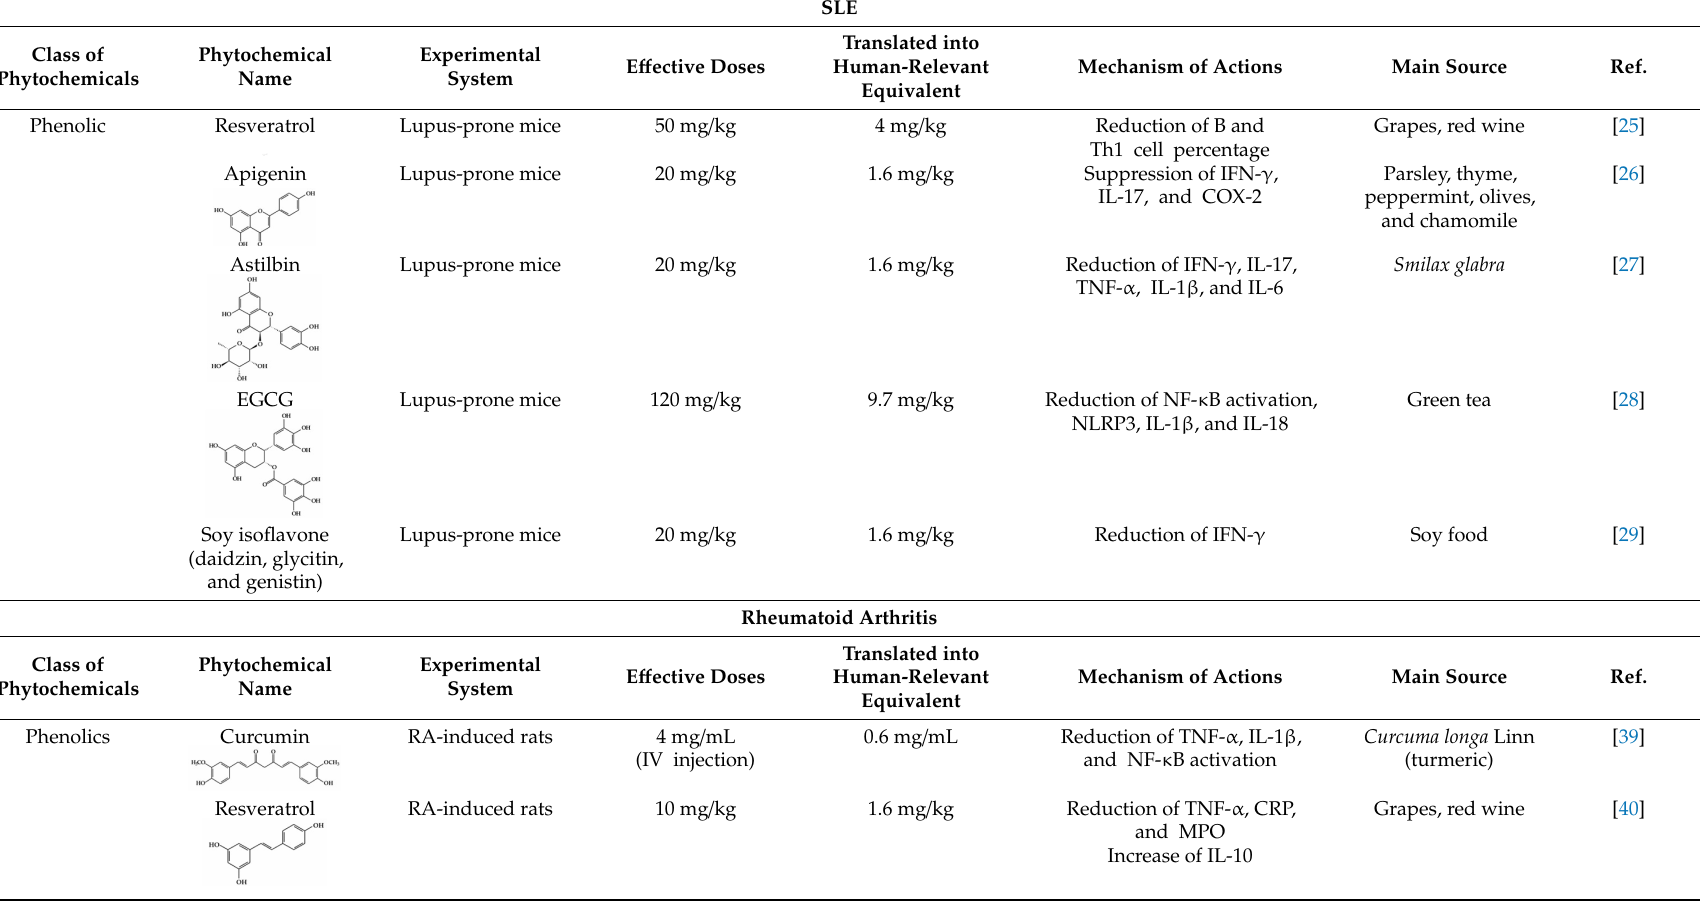
Table 1. Phytochemicals and their e ff ective mechanism in autoimmune